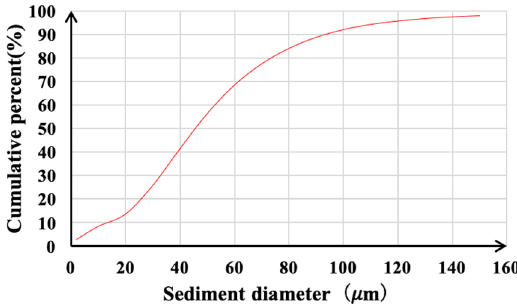
Figure 8. Percentage graph of sediment particle size accumulation of test water.